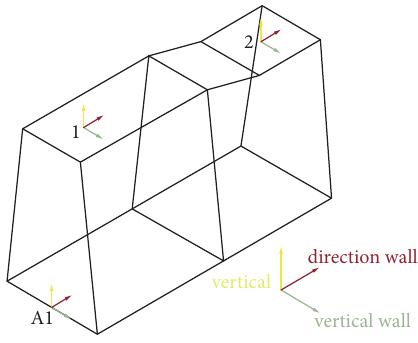
Figure 4: The sensors’ arrangements in the